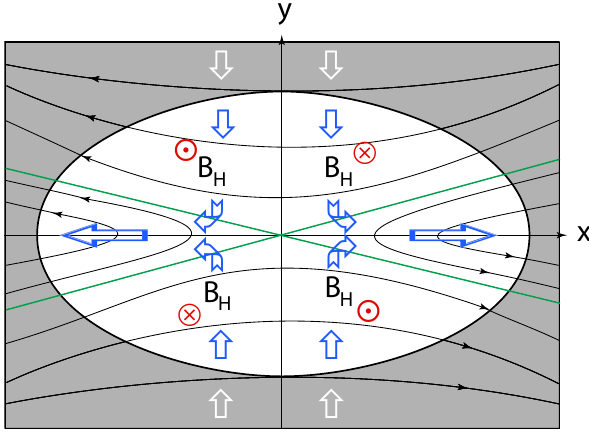
Fig. 3. Schematic geometry of the ion inertial region in the tail cur- rent sheet (white domain) around the reconnection X-line (seen just as an X-point) in collisionless magnetic reconnection. The tail cur- rent is not indicated. In this representation the tail current flows out of the plane while the plasma flows (see the open arrows) in from the top and from the bottom into the centre of the current sheet which includes the X-line and, after having crossed the separatrices (green lines), flows out of the reconnection site (the ion inertial re- gion around the X-line) to both sides. Note that only a very small fraction of the plasma flows through the X-point; the majority of the plasma that participaties in reconnection flows through the ion inertial region and crosses the separatrices (indicated by bent open arrows). Also shown is the quadrupolar structure of the Hall mag- netic field B H indicated by the red circles J , N which have the conventional meaning that the magnetic field vector points either out of or into the